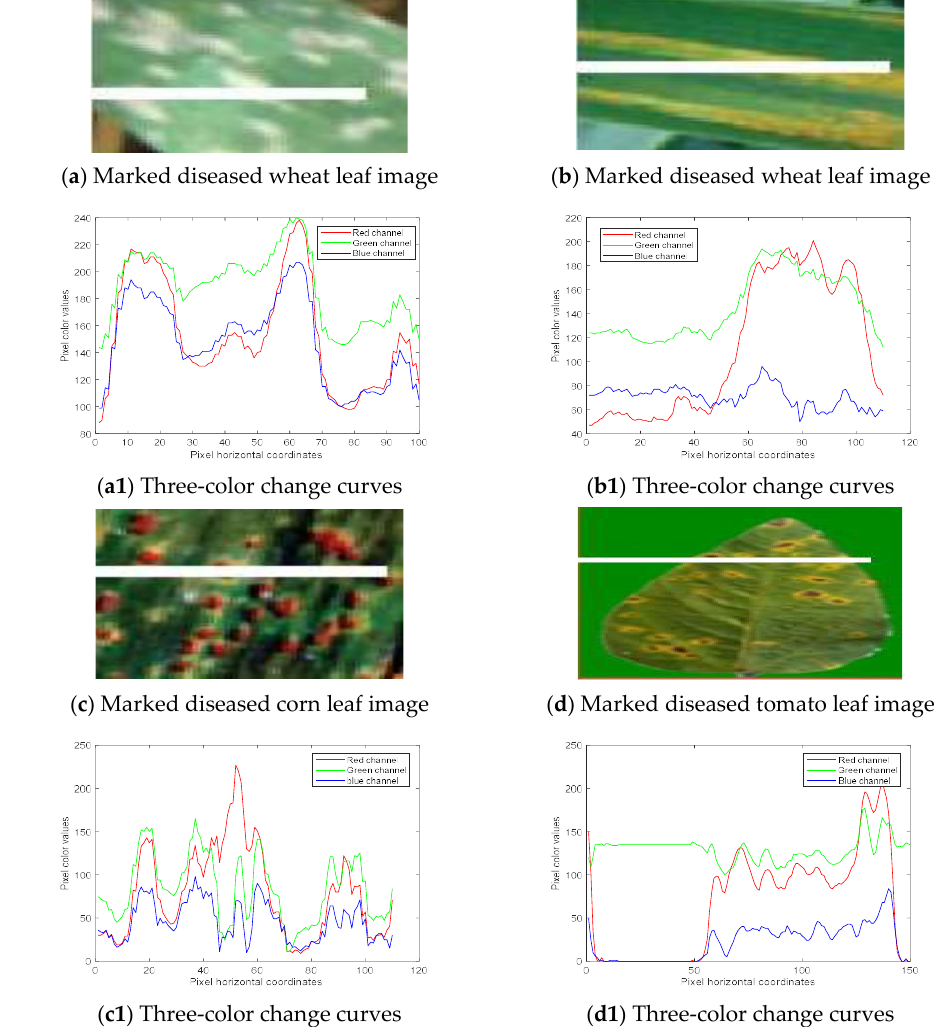
Figure 2. Three-color change curves of the diseased leaves in the RGB color space.